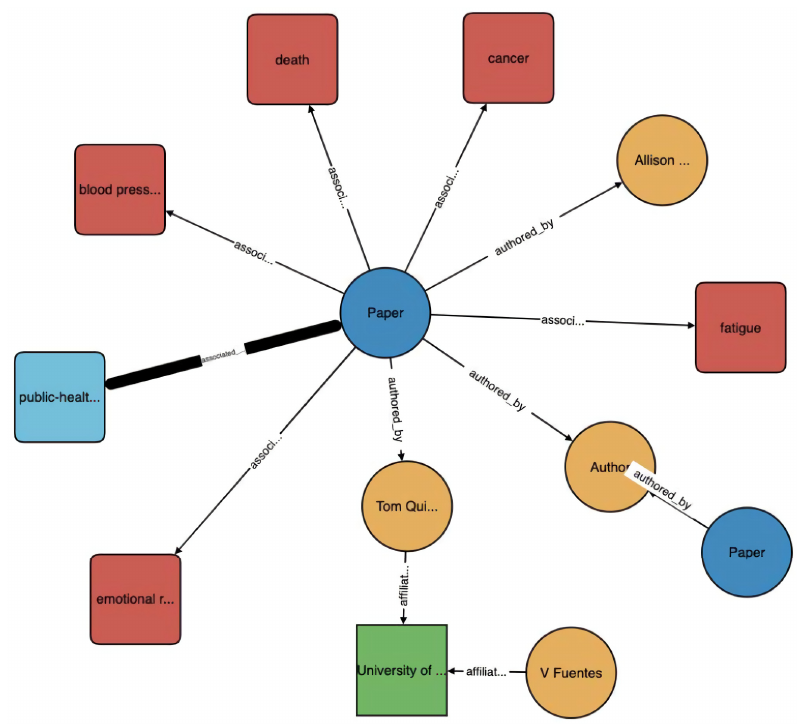
Figure 1. Visualization of a knowledge graph (KG). Paper entities (blue) connect to concepts (red), topics (light blue), and authors (gold) through directed relations. Authors connect to institutions (green). Reproduced with permission from Wise et al. [14].